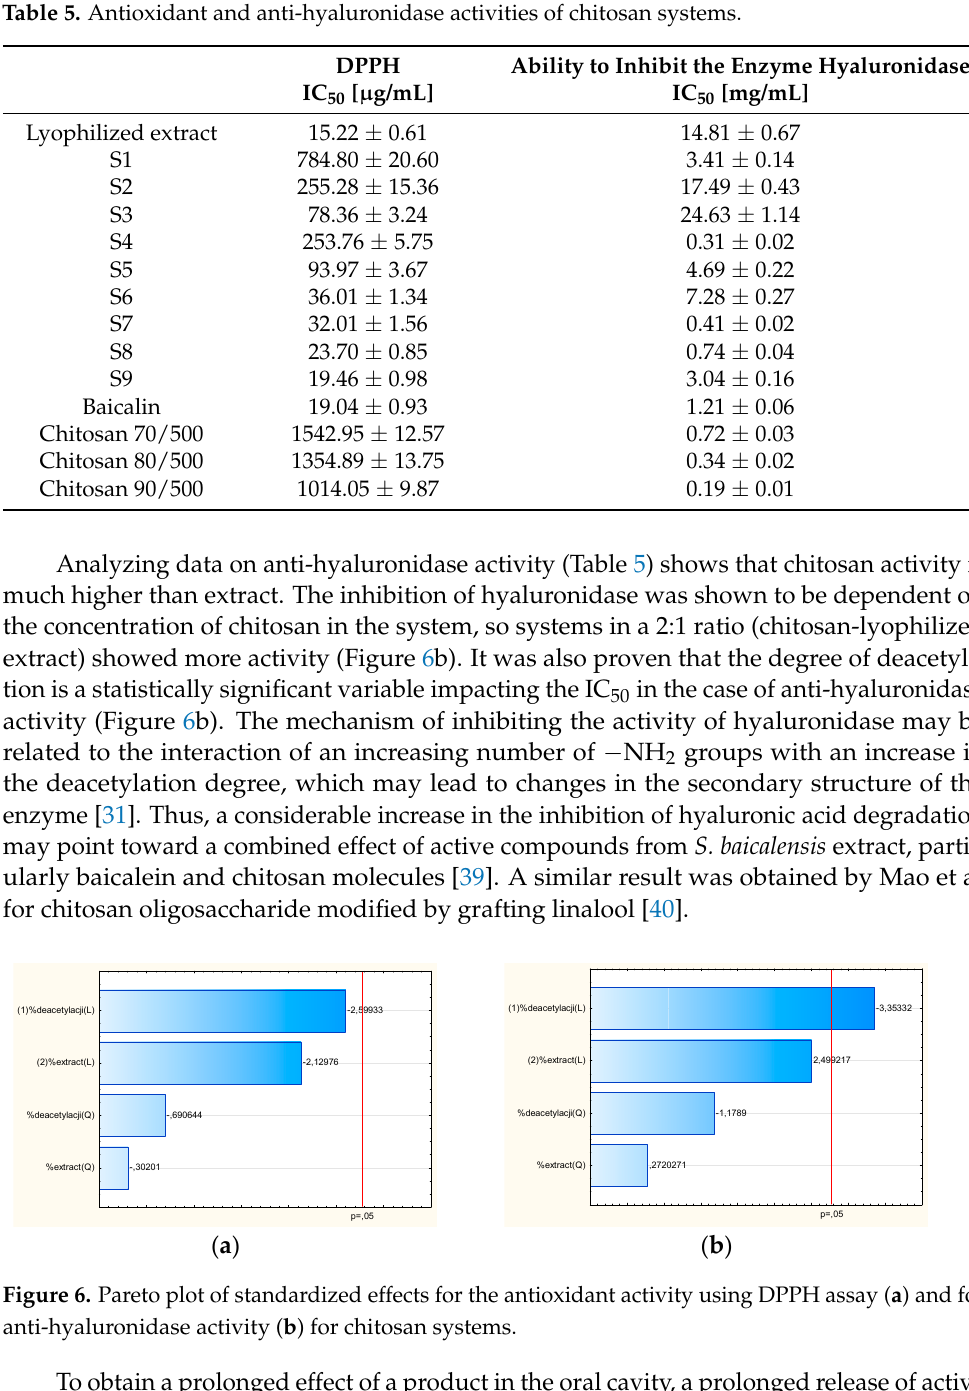
Table 5. Antioxidant and anti-hyaluronidase activities of chitosan systems.